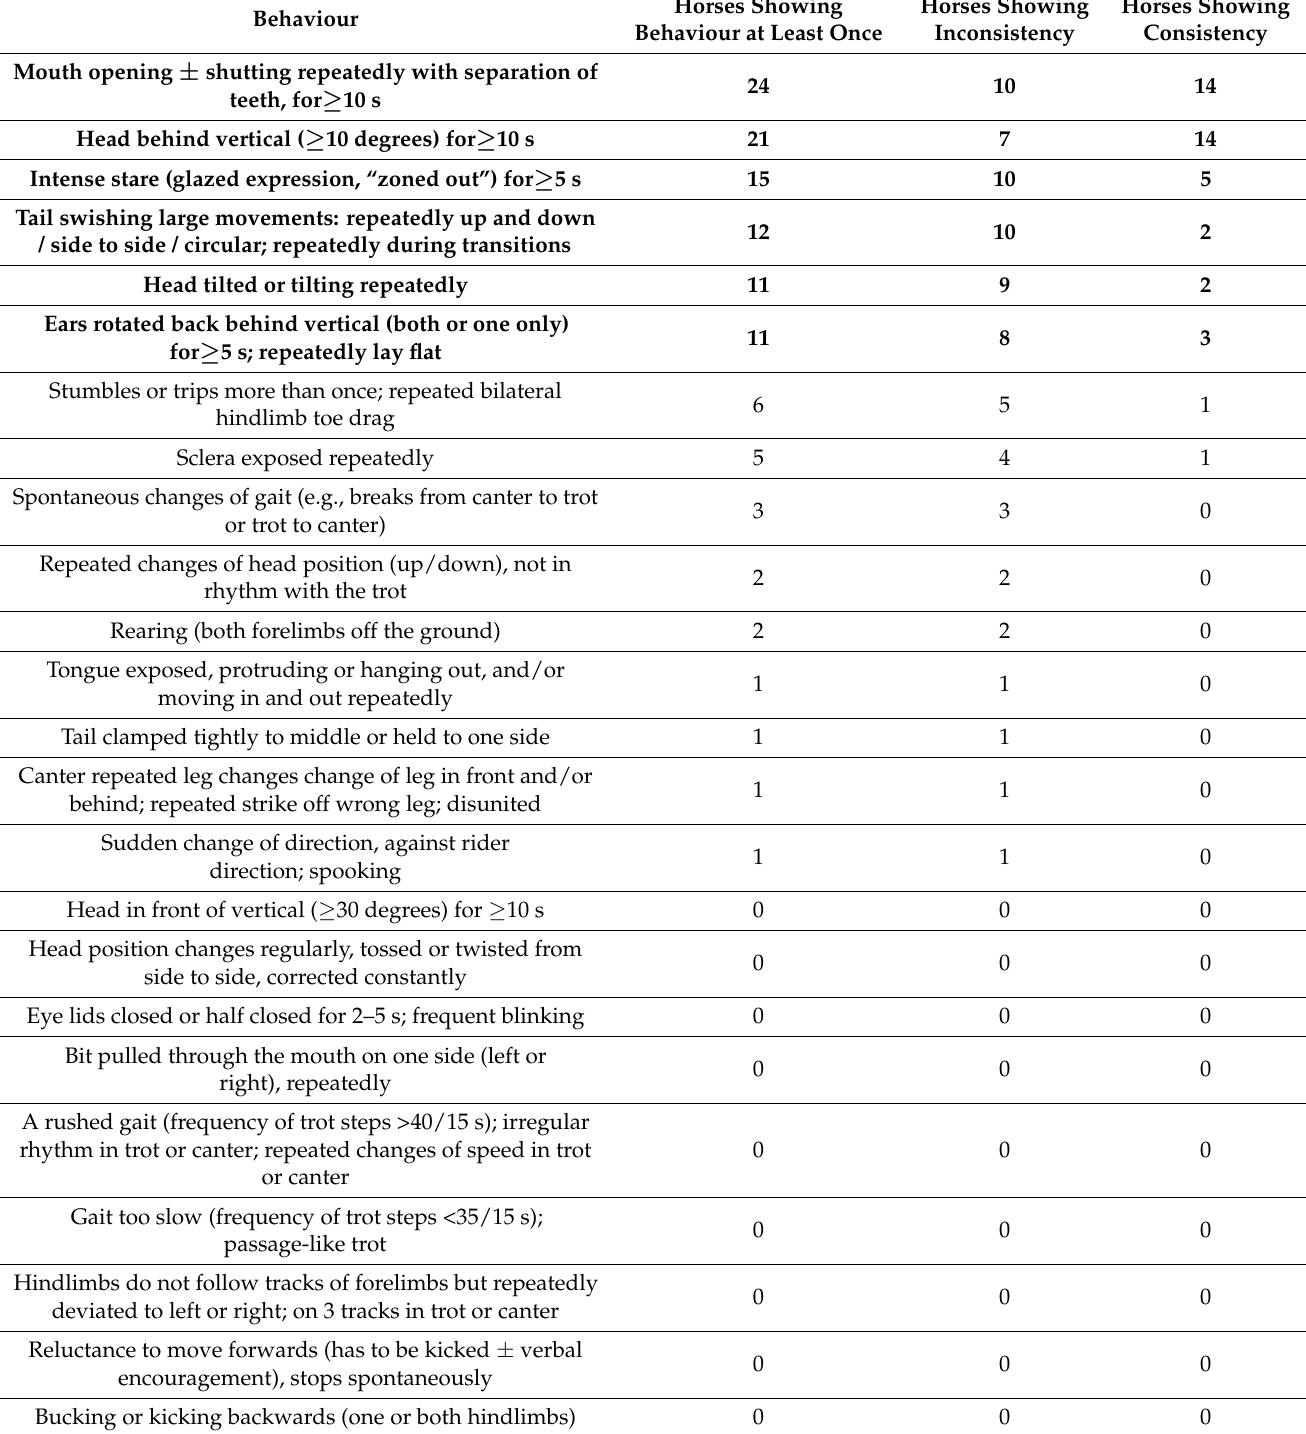
Table 6. Consistency of observations of the 24 behaviours of the Ridden Horse Pain Ethogram displayed by 27 horses assessed on two ( n = 18), three ( n = 5), four ( n = 3), and five ( n = 1) occasions competing at World Grand Prix Dressage Western League qualifying competitions ( n = 7) or finals ( n = 2). The six most frequently observed behaviours (observed in >10 horses) are in bold. Horses Showing Horses Showing Horses Showing Behaviour Behaviour at Least Once Inconsistency